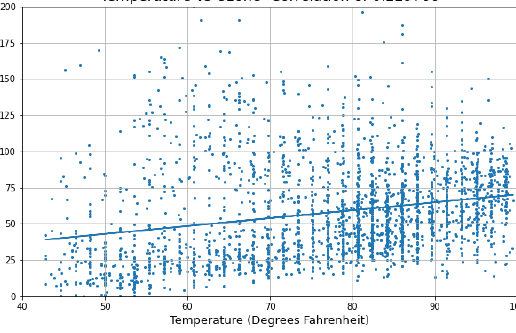
Figure 3. Individual correlations between variables and ozone, with best fit line and correlation in label. Each point is a single hour, and data for the year 2015 are